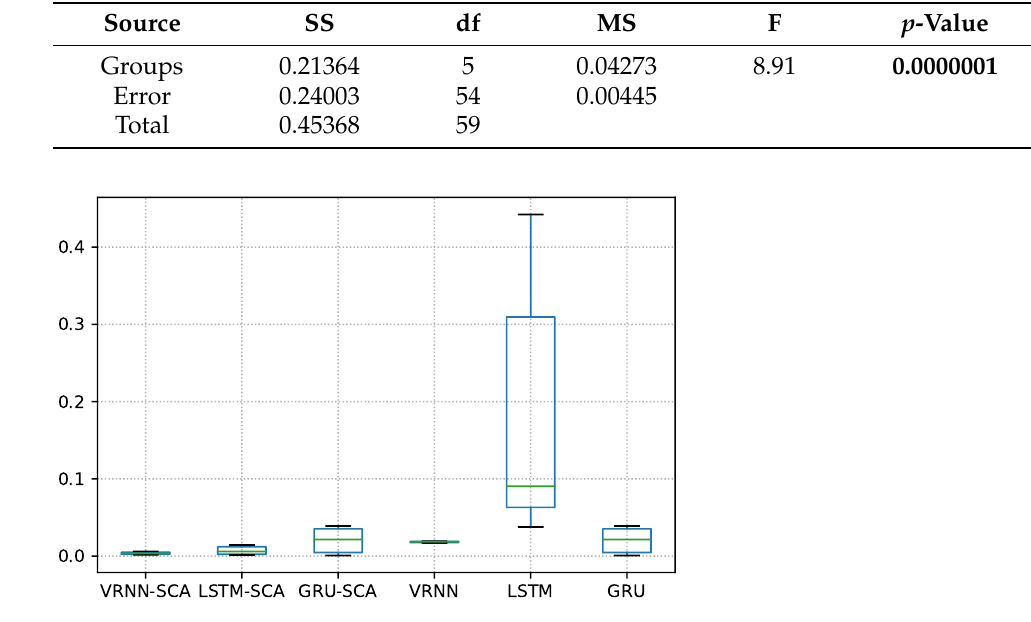
Figure 16. Boxplot differences on the 41040 dataset.